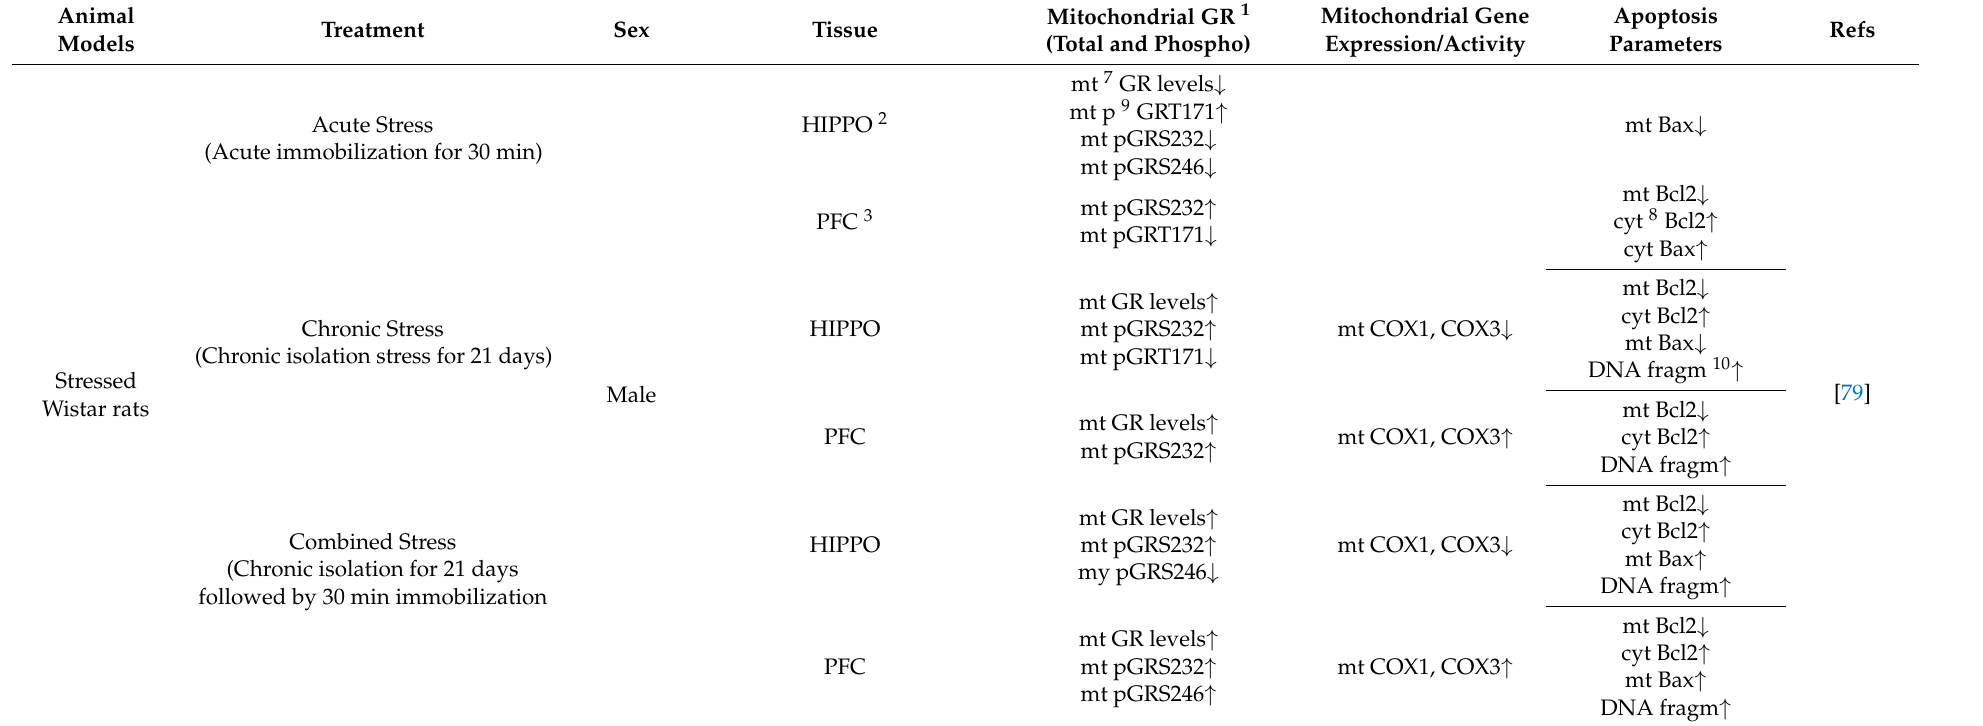
Table 3. Mitochondrial GR (total GR and phosphoGR isoforms) and apoptosis-related alterations in stressed